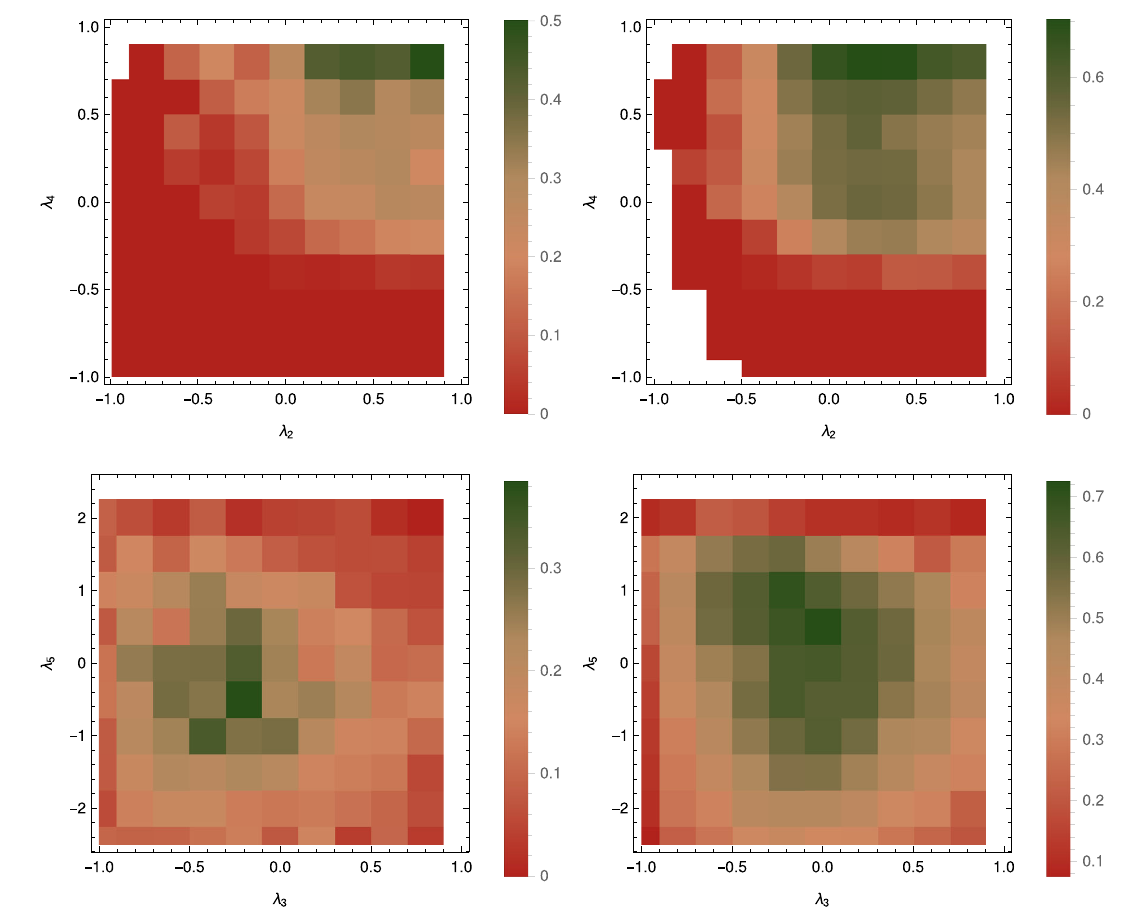
Fig. 19 Fraction of those points out of the parameter scan which are stable at one-loop and also pass the tree-level constraints. The results are shown in the (λ 2 ,λ 4 ) (upper row) and the (λ 3 ,λ 5 ) plane (lower row). The left column uses the points with the input choice I, the right column uses Input